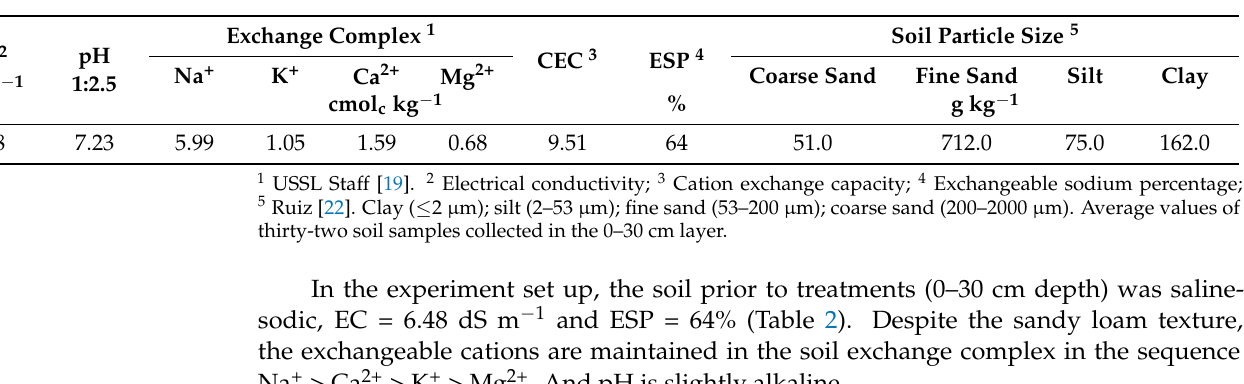
Table 2. Soil chemical characteristics and particle size distribution of the soil collected at the experi- ment set up (0–30 cm